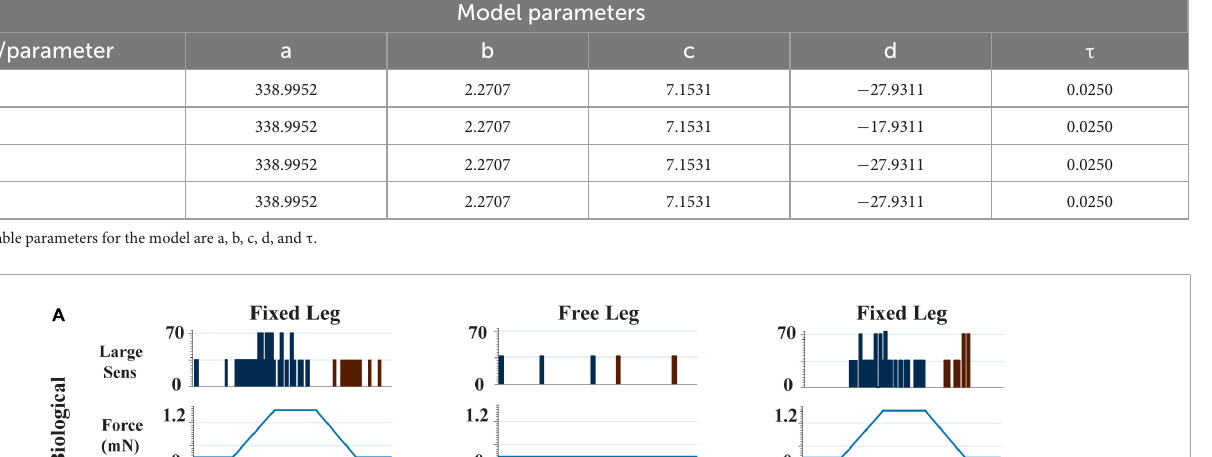
Model parameters